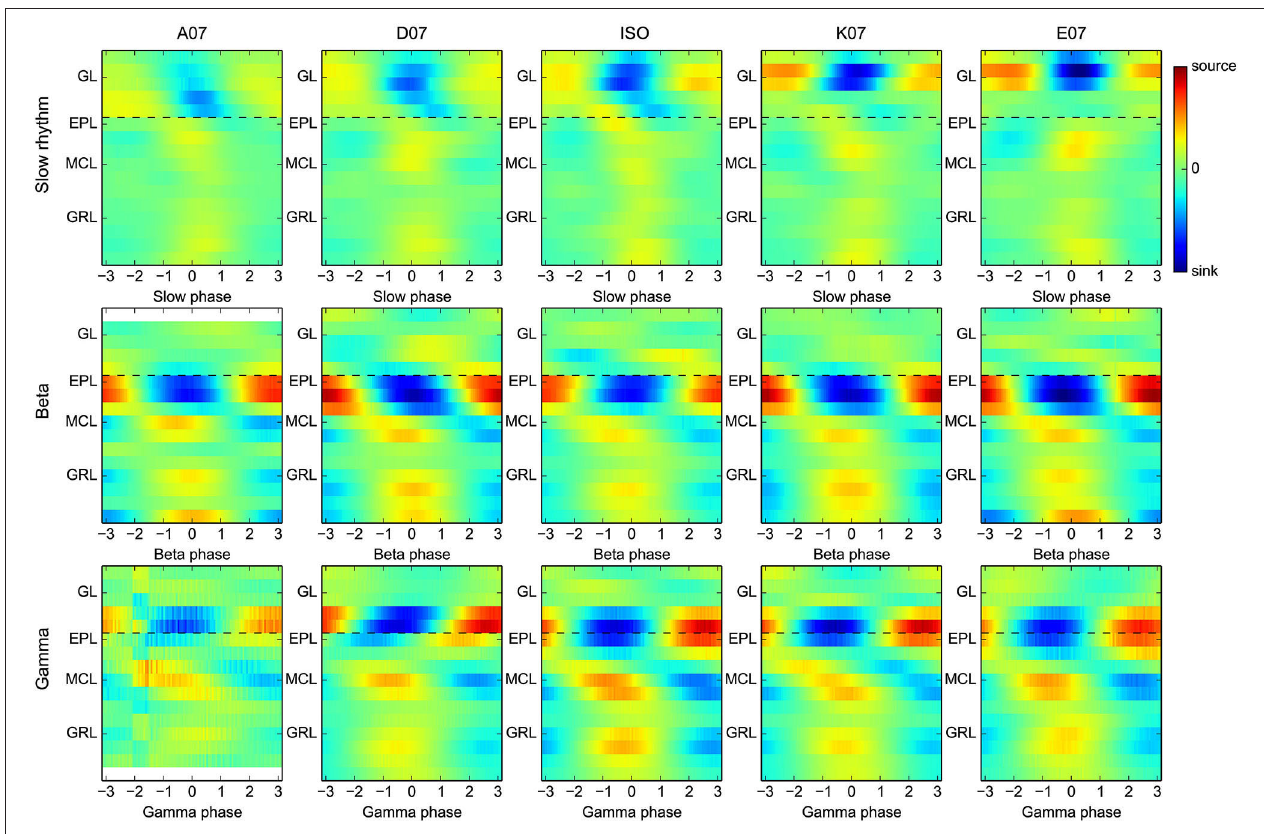
fast (gamma and beta) oscillation maps. Black dashed lines are only plotted to provide a visual guide. Note all 18 recording sites have been stimulated with all five odors, but gamma or beta oscillations were not always generated and detected. Thus, slow oscillation group CSD maps are averages across the 18 sites, whereas gamma and beta maps are averages of (in plot order) N = 10, 12, 12, 13, 14 and N = 3, 17, 13, 18, 18,